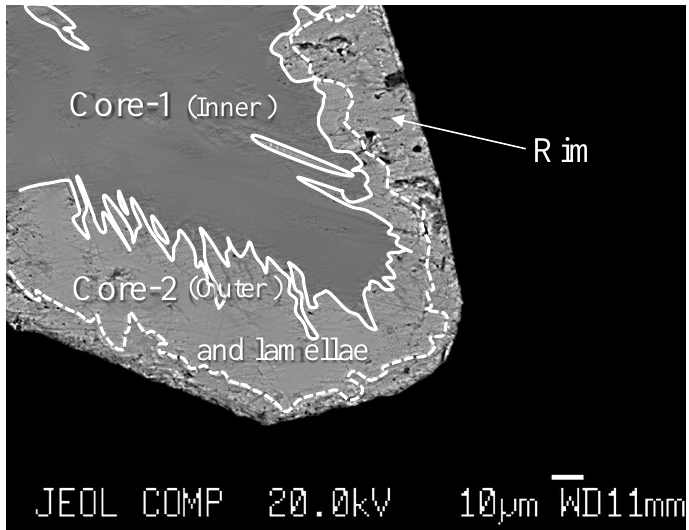
Figure 5. Sulfide inclusion in olivine from the Udachnaya kimberlite (Yakutia): BSE image of mss: Core-1 (inner), pentlandide Core-2 (outer), and chalcopyrite rim. The compositions of the zones are shown in Table 3.